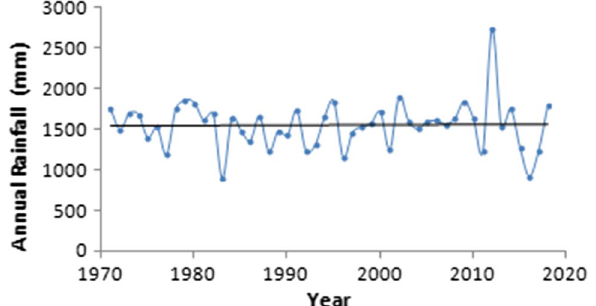
Fig. 1 Annual rainfall of the